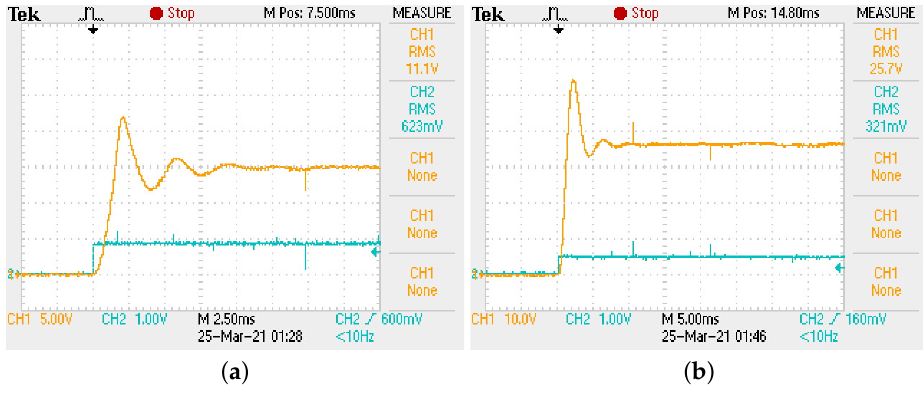
Figure 13. Tracking characteristic of buck–boost converter. ( a ) Buck mode. ( b ) Boost